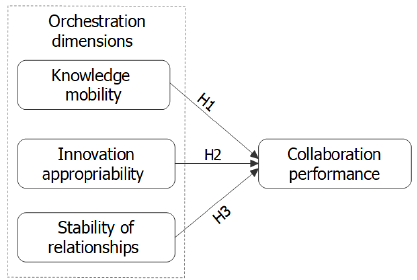
Figure 1. The research